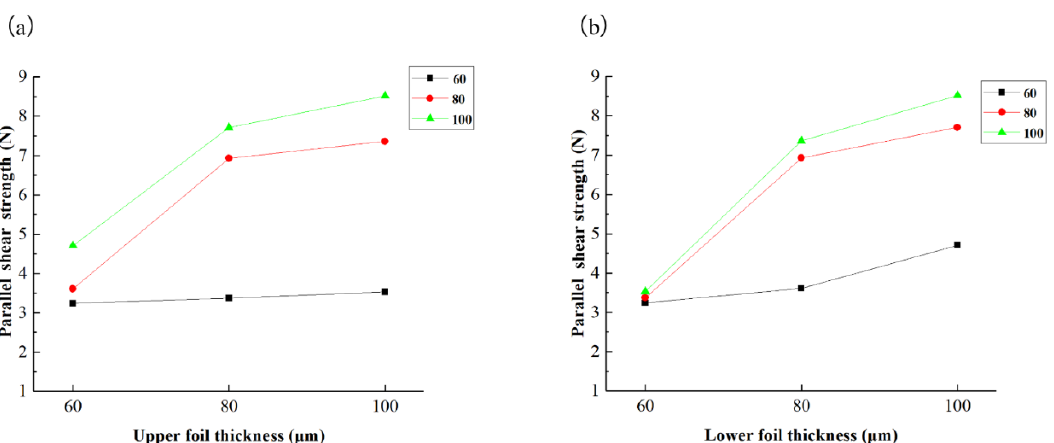
Figure 24. Parallel shear strength of different thickness combinations: ( a ) influence of upper foil thickness and ( b ) influence of lower foil thickness.